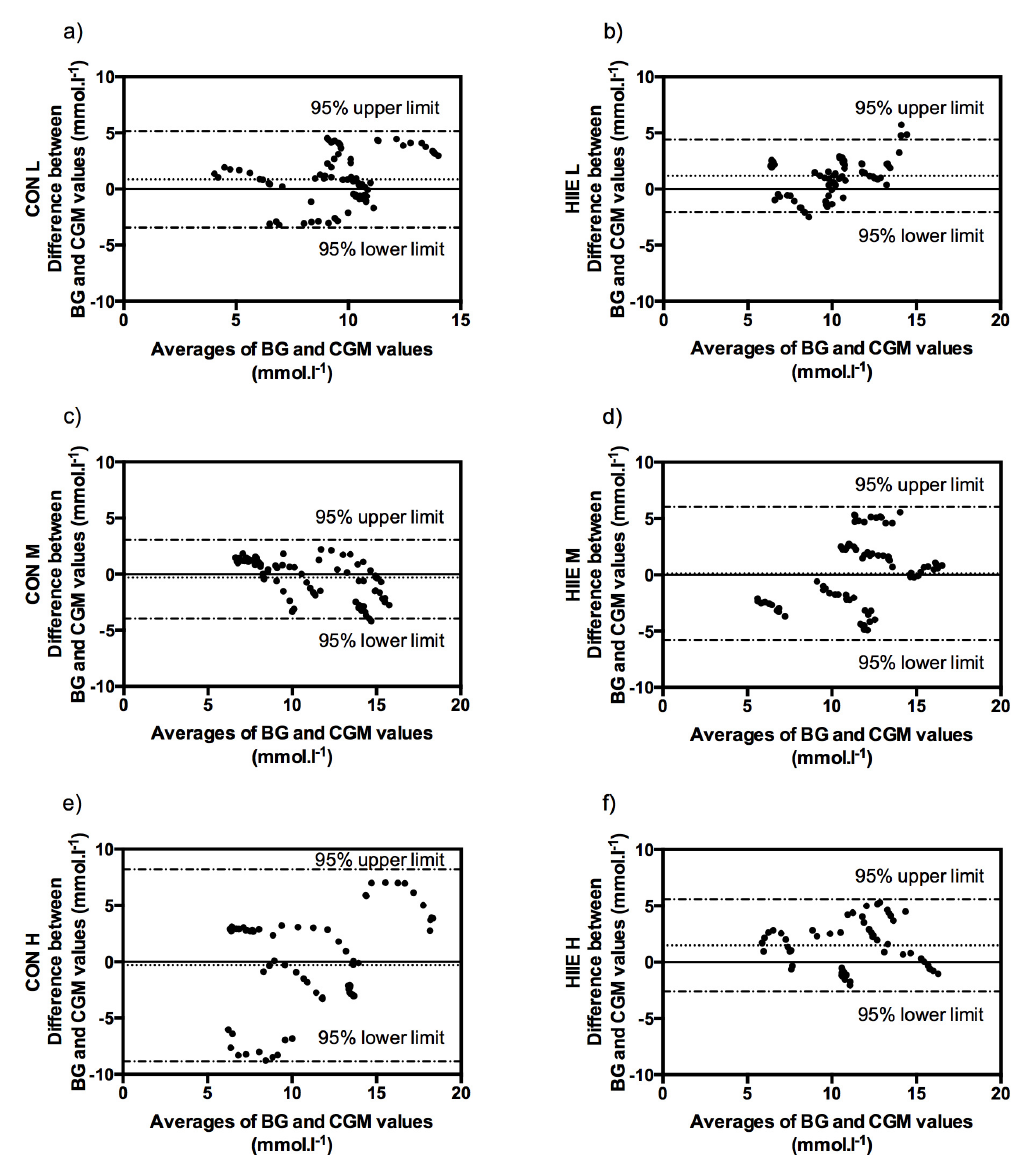
Figure 4. Bland ‐ Altman plots for the comparison of BG and CGM values during CON and HIIE for the three standardized mean exercise intensities given as bias (dotted line) and levels of agreement (dot ‐ dashed line): CON for exercise intensities L ( a ), M ( c ), and H ( e ); as well as HIIE for exercise intensities L ( b ), M ( d ), and H ( f ).